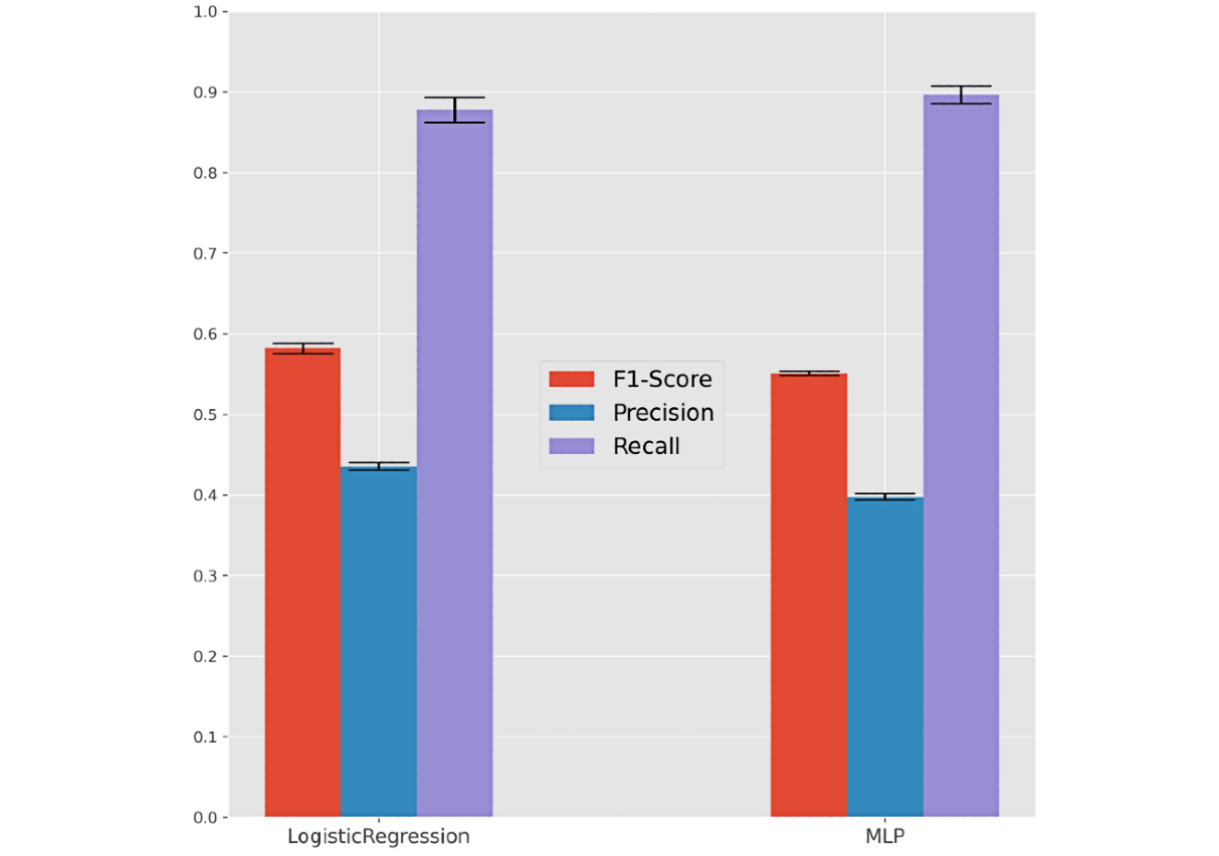
Figure 4. Predictability of hospitalizations for individuals testing SARS-CoV-2 positive. Recall, precision, and F1 for the best predictors in F1 (left) and recall-oriented (right) scores on the validation set after nested cross-validation. MPL: multilayer